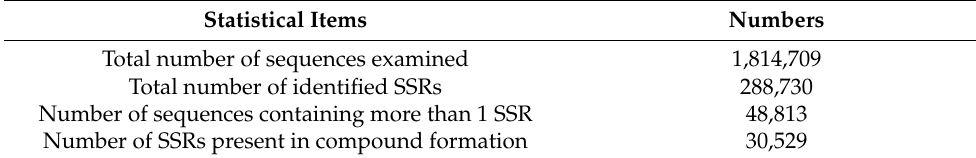
Figure 4. GC content and depth correlation analysis of the shimofuri goby. The x axis denotes the percentage GC content and the y axis represents sequencing depth. Table 2. Statistics of microsatellite recognition